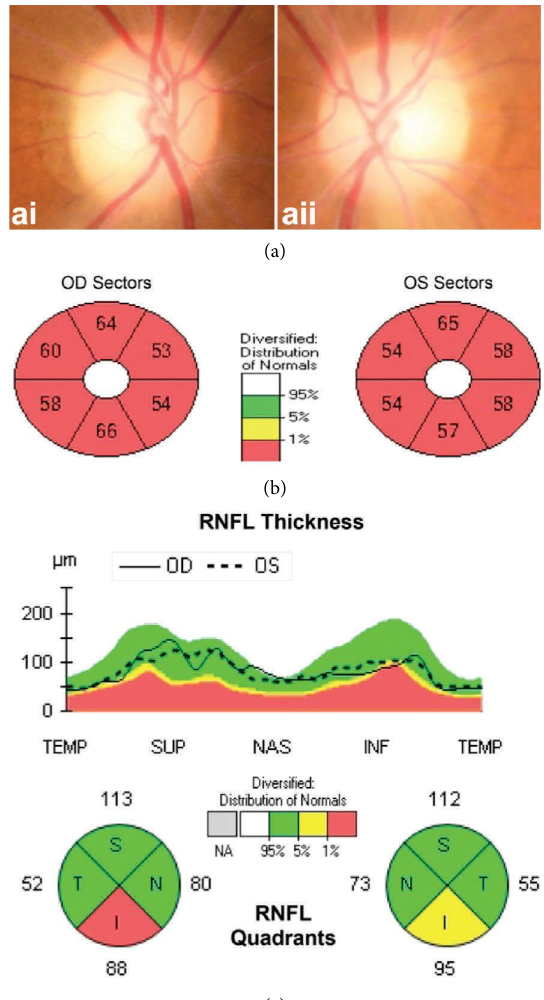
Figure 5: As the disease progressed, pRNFL decreased, and mGCL-IPL thinning became more severe. (a) (i, ii) the optic nerve is relatively normal in the fundus photograph. (b) OCT identifed severe mGCL+IPL thinning. (c) OCT identifed mild pRNFL